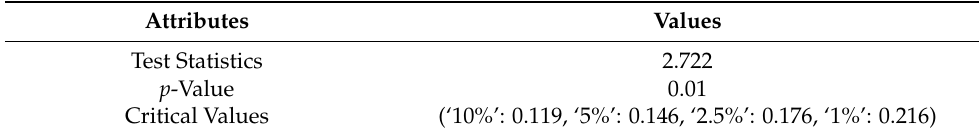
Table 1. Results of the KPSS test on traffic speed